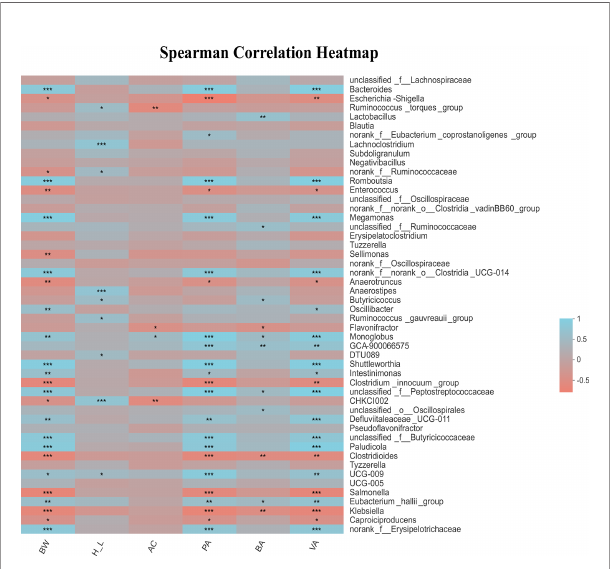
FIGURE 8 | Heatmap analysis of KEGG pathways (level 3) of SE-infected high and low H/L chickens at 7 and 21 dpi (n = 3). Red, high KO abundance; blue, low KO abundance.